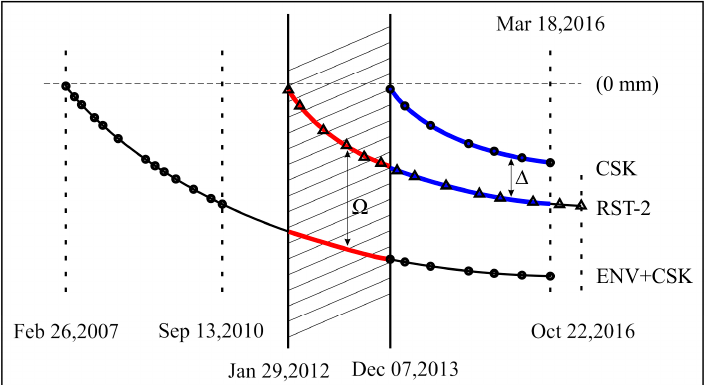
Figure 4. Pictorial representation of the procedure adopted to align the vertical RST-2 ground deformation time-series with that of the ENV+CSK SAR data set.